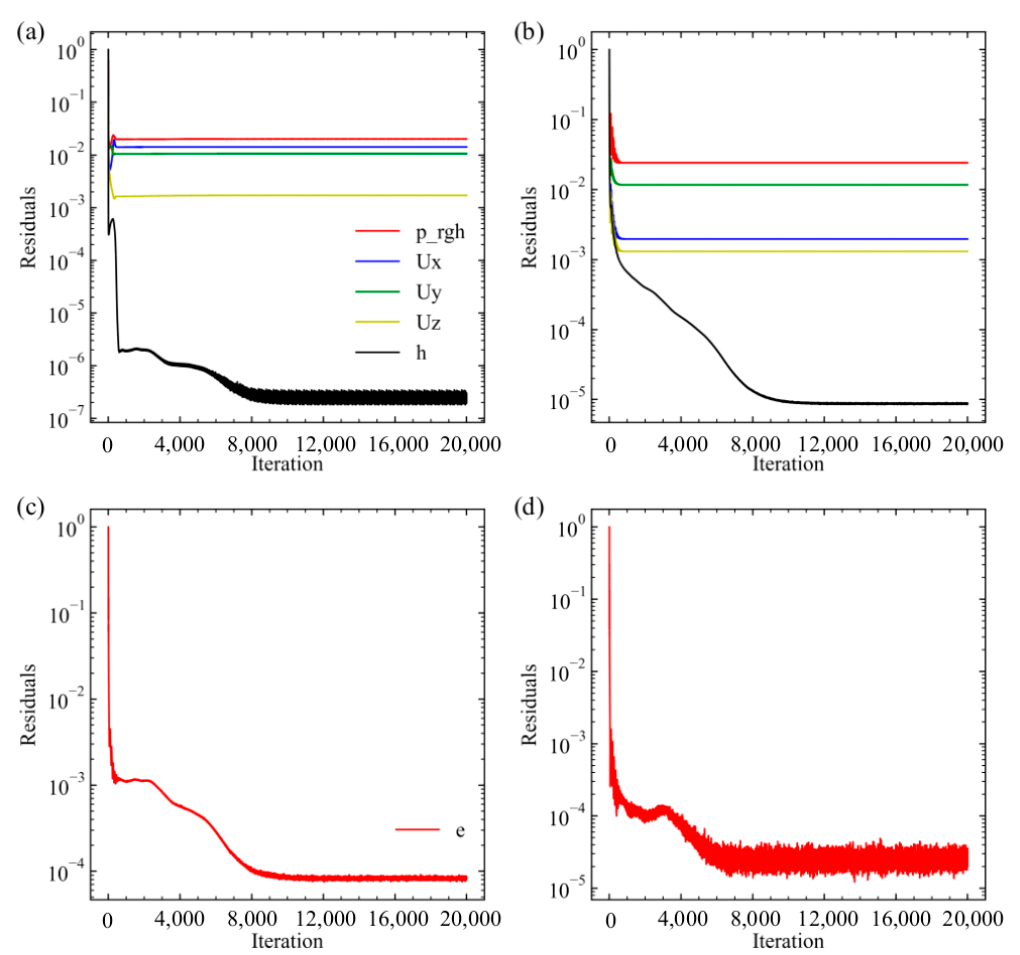
Figure 11. Distributions of the y + on the wall boundaries of ( a ) air and ( b ) water regions.